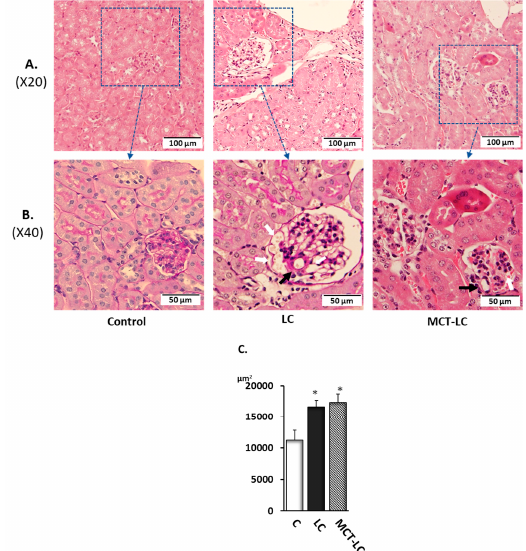
Figure 3. Renal morphological observation by HE staining ( A ), Periodic acid-Schiff staining ( B ) (white arrows indicate enlargement of small vessels, black arrows indicate imported arterioles hypertrophy with vessel wall thickness ), and measurement of glomerular area ( C ). Data shown are mean ± SEM. Control, control diet; LC, low-carbohydrate diet high in lard; MCT-LC, low-carbohydrate diet high in medium-chain triglyceride. * p < 0.05 vs. control by Tukey’s HSD test.